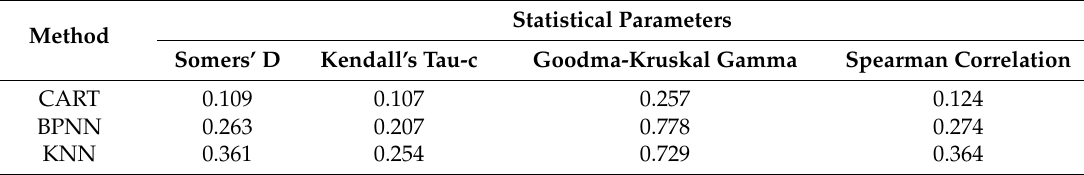
Table 7. Statistical measures of the goodness of fit for the traditional single-date VIs-based CART, BPNN, and KNN models.